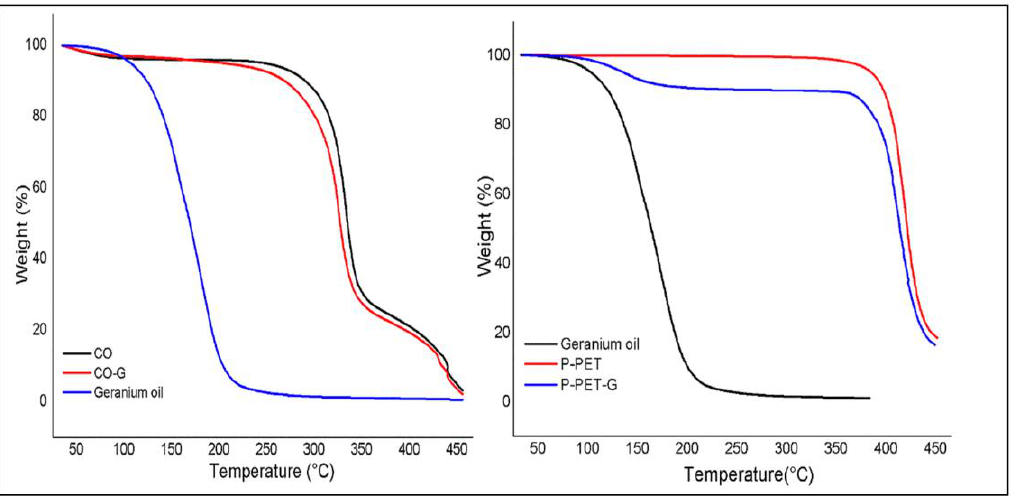
Figure 6. TGA curves of geranium oil, cotton, polyester fabrics, and their modified counterparts.